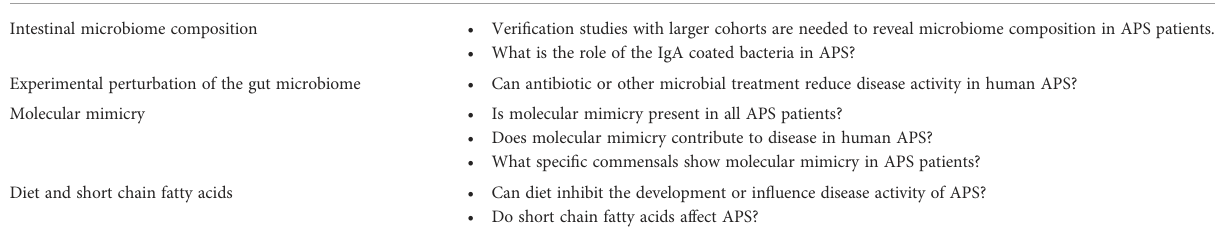
TABLE 1 Open questions in the APS-microbiome fi eld. Findings relevant for